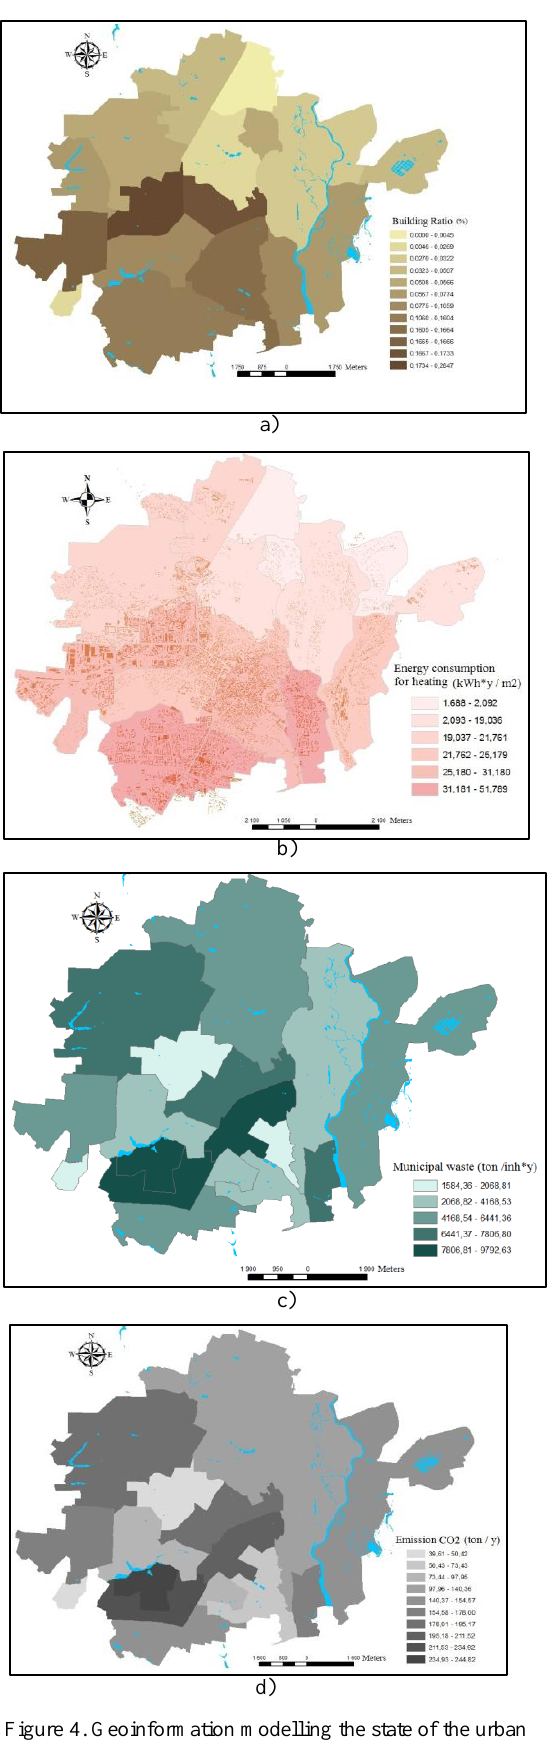
environment indicators: а) building ratio (%), b) energy consumption for hearting (kWh∙y / m 2 ), c) municipal waste (ton / inh∙y), d) emission CO 2 (ton / inh∙y)